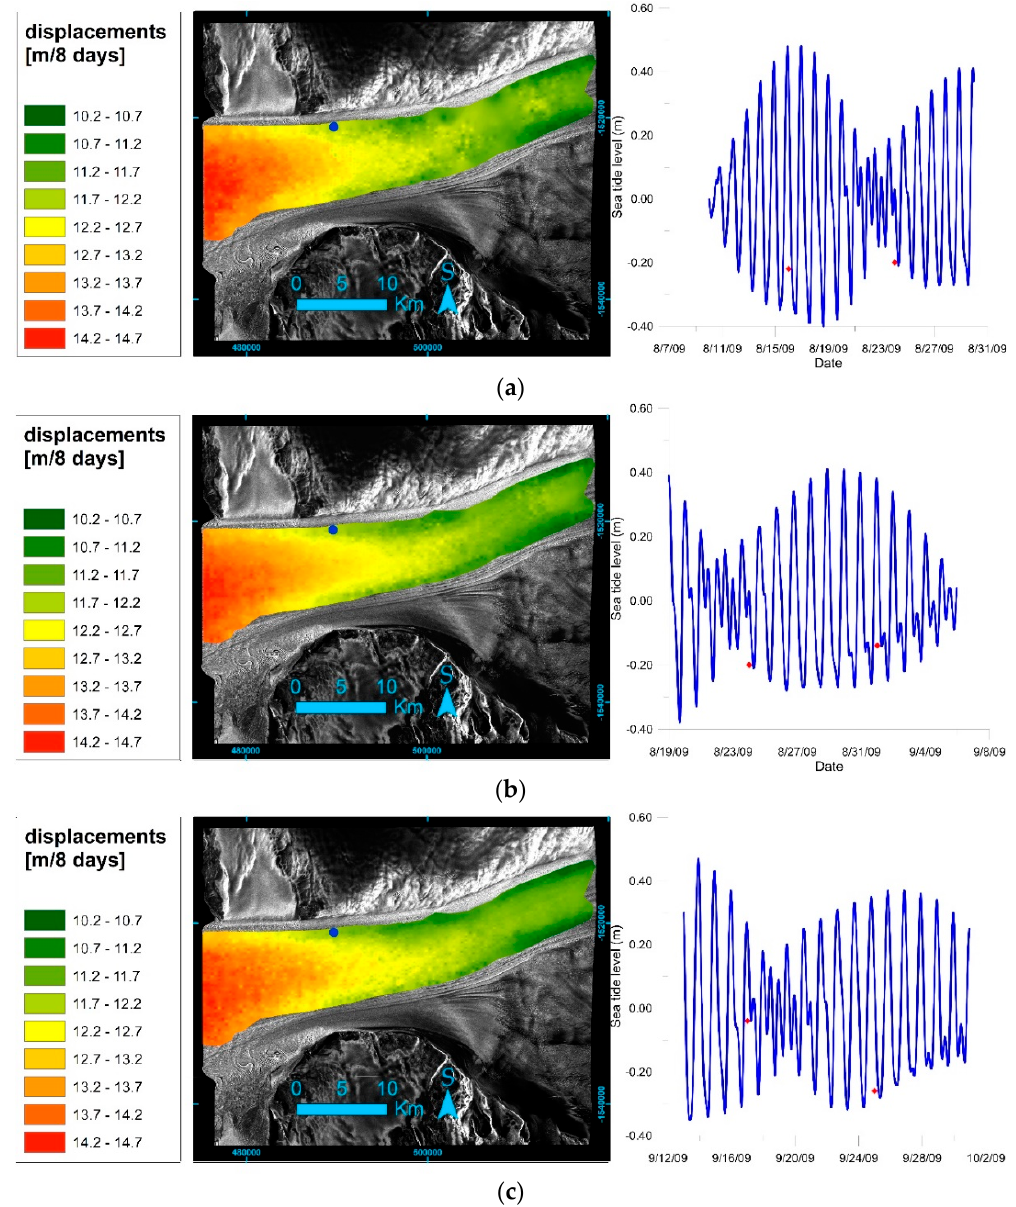
Figure 9. On the left, grids obtained interpolating the horizontal component of the offset points on the floating part of southern flux of the David Glacier, from top to bottom, respectively, pair I ( a ), pair II ( b ), and pair III ( c ). The blue dot corresponds to the position of DRY1 GPS point. Coordinates are expressed in Antarctic Polar Stereographic mapping projection. On the right are graphs reporting the timing of SAR image acquisition with respect to the predicted ocean tide variations. The red dots in the graphs correspond to the master and slave scenes of the three image-pairs.